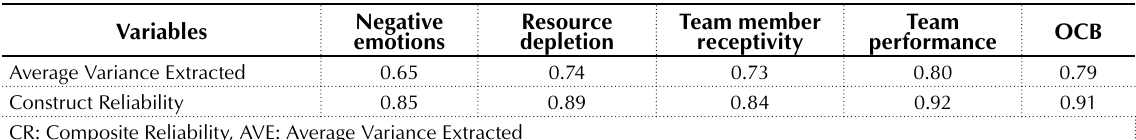
Table 4. Factor correlation